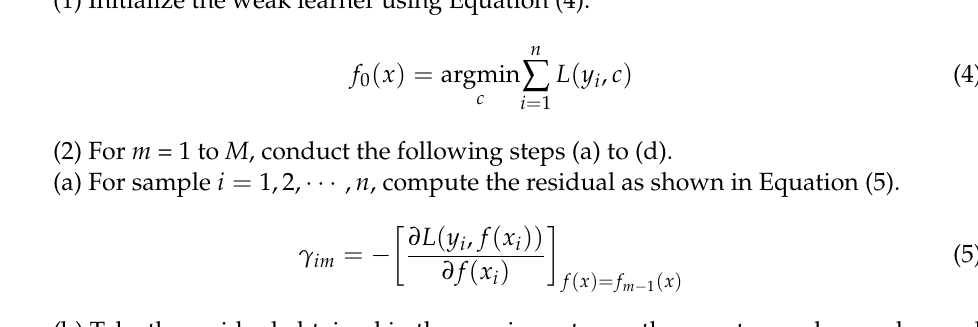
Figure 5. Diagram of bagging and boosting: ( a ) bagging; ( b ) boosting. For a training set { ( x i , y i ) } n , a differentiable loss function L ( y , f ( x )) , and number of iteration M , the steps as follows can be used to conduct a GBDT.